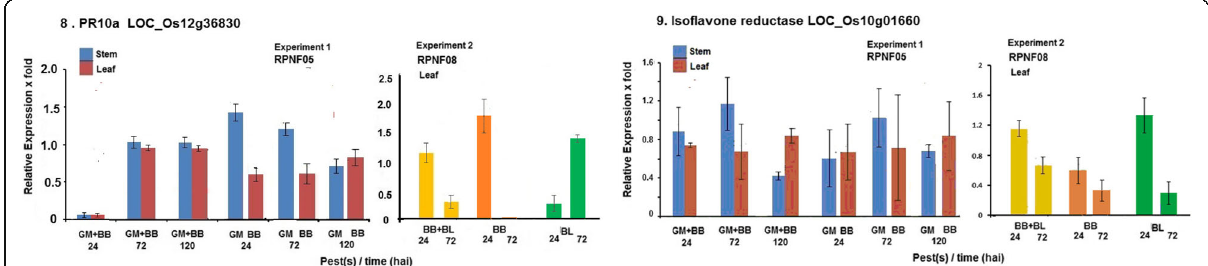
Fig. 3 Relative levels of expression of PR10a and Isoflavone reductase in rice line RPNF05 following challenge by BB and/or GM (Experiment 1) or in RPNF08 following BB and/or BL infection (Experiment